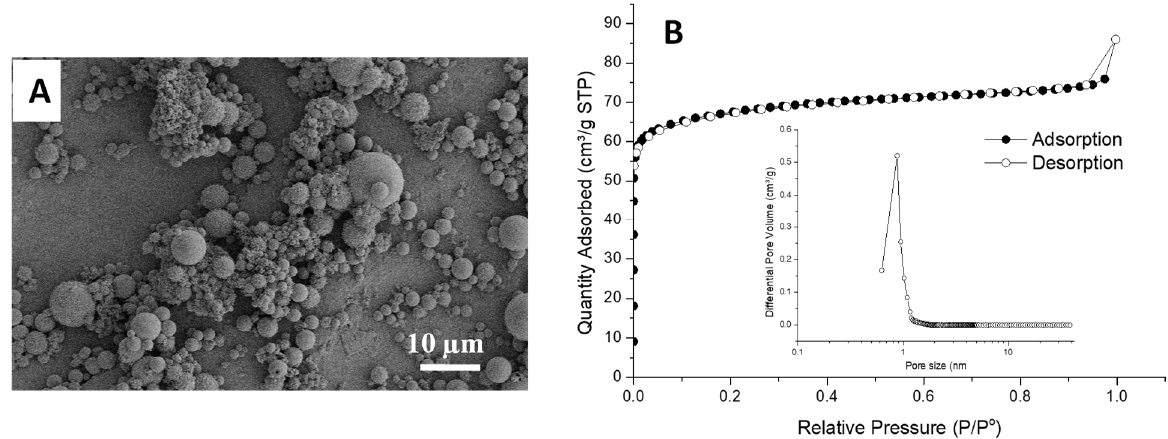
Figure 3. Characterisation of MPTMS–silica–PAM composite beads after being calcined at 550 °C. ( A ) The SEM image; ( B ) the N 2 sorption profile with the inset showing pore size distribution calculated by NLDFT method.